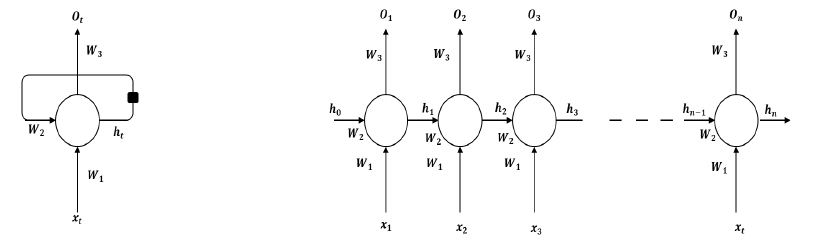
Figure 1. The structure of Recurrent Neural Network (RNN) for n inputs.